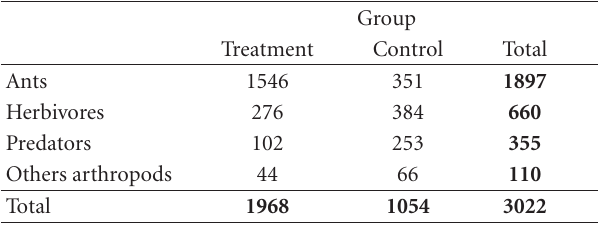
Table 3: Total number of occurrences registered for each experi- mental group throughout the experiment.